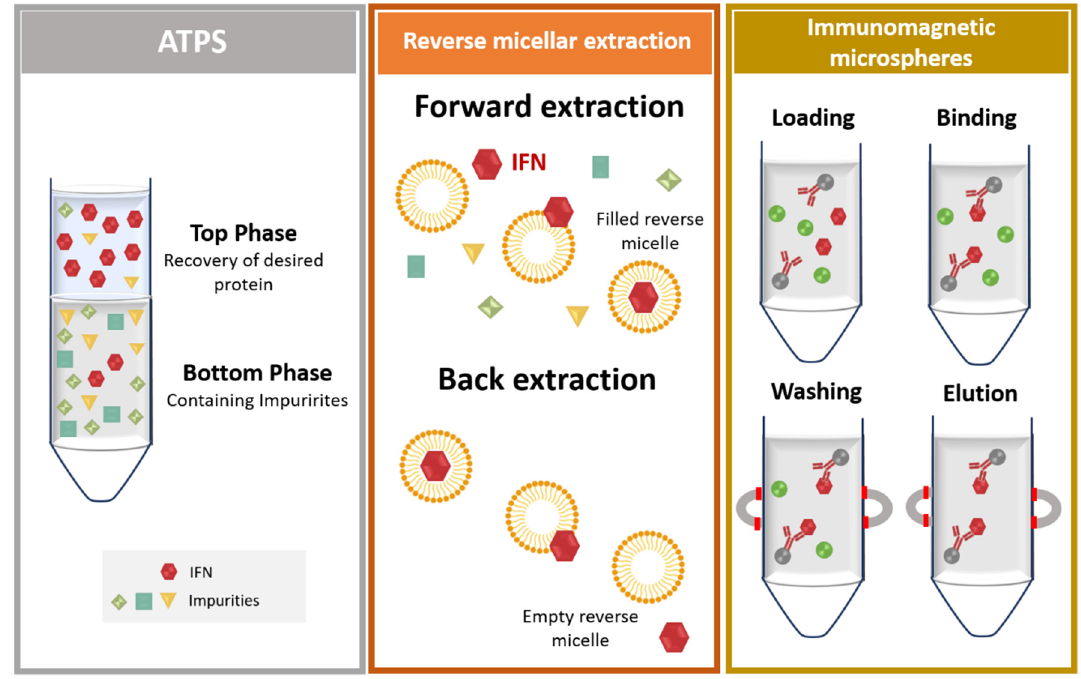
Figure 8. Separation principles of alternative techniques applied for the purification of IFNs (ATPS–Aqueous two-phase system).